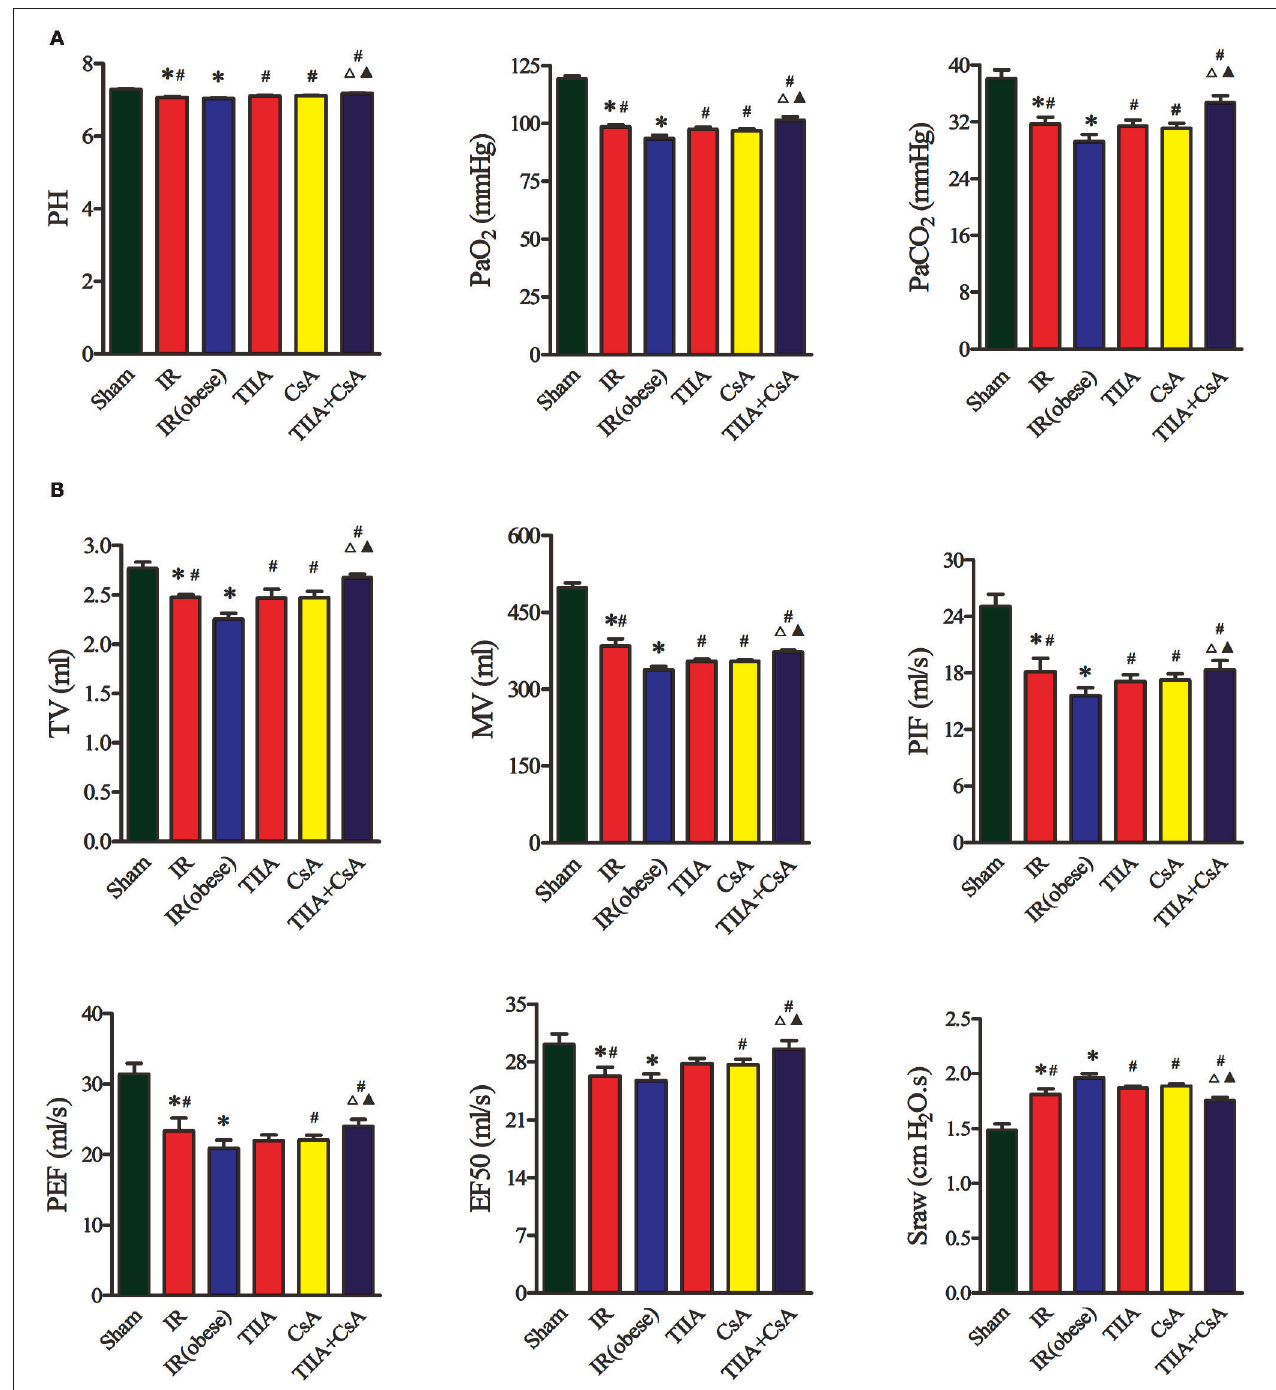
FIGURE 1 | Tanshinone IIA (TIIA) + cyclosporine A (CsA) improved the arterial blood gas and pulmonary function induced by renal ischemia-reperfusion (IR). Rats were pretreated with TIIA alone or in combination with CsA followed by removing the right kidney and clamping of the left renal artery for 30min and reperfusion for 24h. Sham rats were used as control. Representative arterial blood gas (A) and pulmonary function (B) were evaluated under different conditions. The scale bars represent a length of 200 µ m on histology. Data are shown as mean ± SD. * p < 0.05 vs. sham group, # p < 0.05 vs. IR (obese) group, 1 p < 0.05 vs. TIIA group, N p < 0.05 vs. CsA